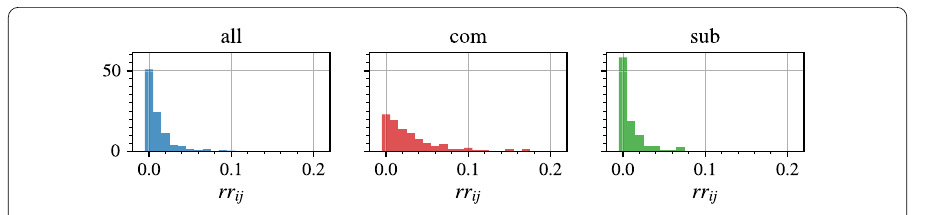
Figure 12 Distributions of the relative number of shared recipes of all product pairs { rr ij } (“all”), of complementary pairs { rr ij : W ( c ) > 0 } (“com”) and of substitute pairs { rr ij : W ( s ) ij